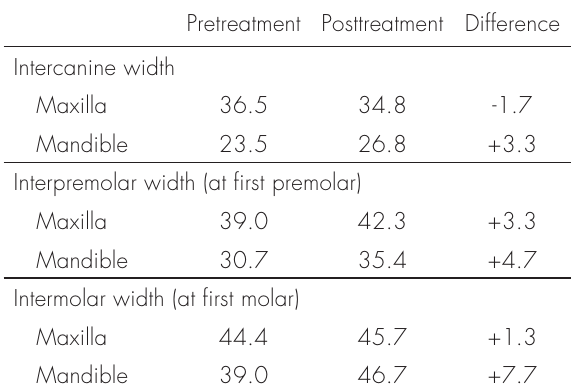
Table II. Dental arch width changes (mm).